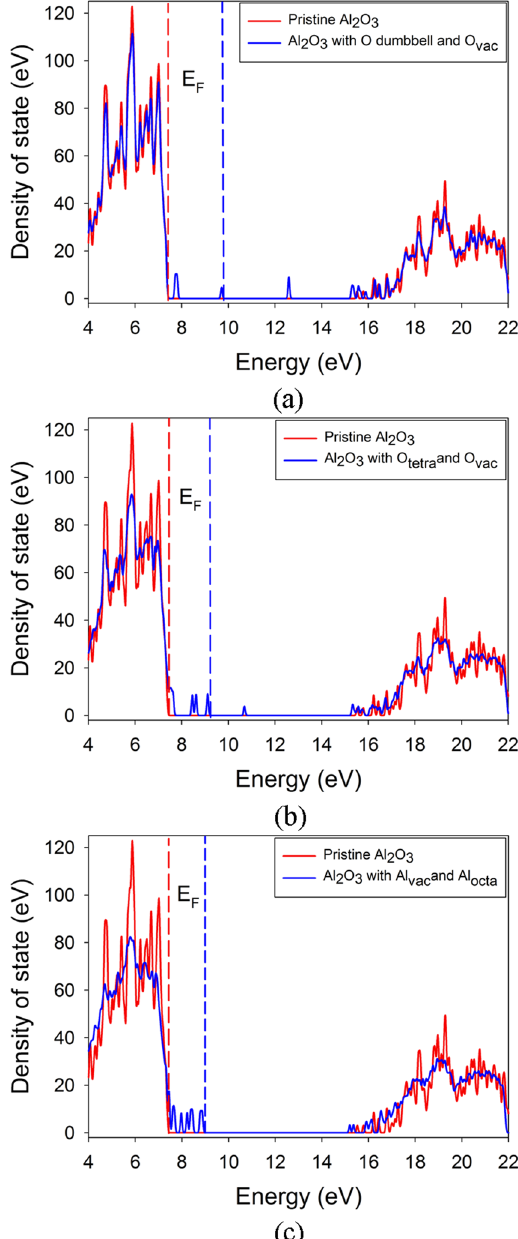
Figure 4. Total density of state distribution for ( a ) α -Al 2 O 3 with oxygen vacancy and oxygen dumbbell pair; ( b ) α -Al 2 O 3 with oxygen vacancy and oxygen interstitial occupying the tetrahedral site; ( c ) vacancy and aluminum interstitial occupying the octahedral site. E F indicates the Fermi